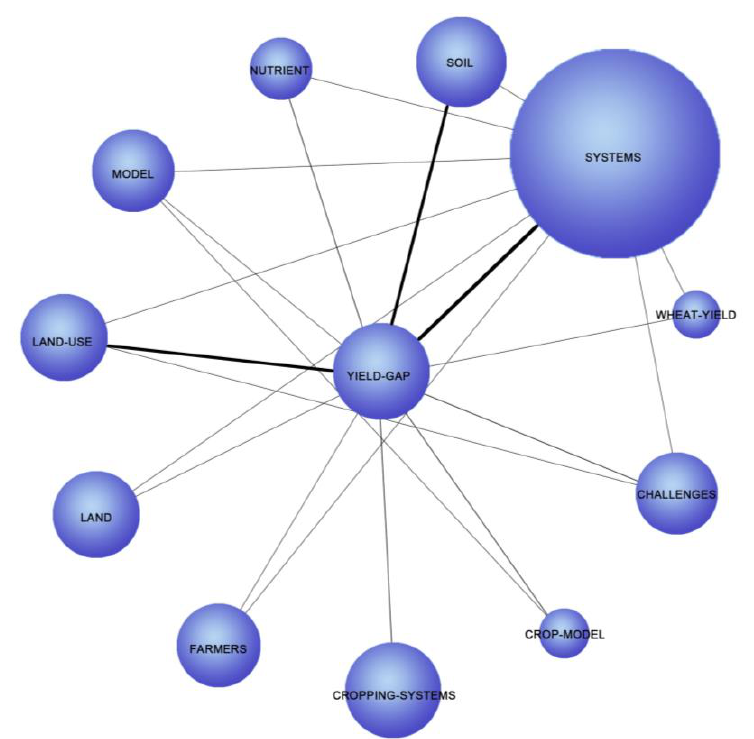
Figure 6. Yield gap of the agricultural sustainable intensification theme cluster network diagram. Data source: Web of Science Core Collection.